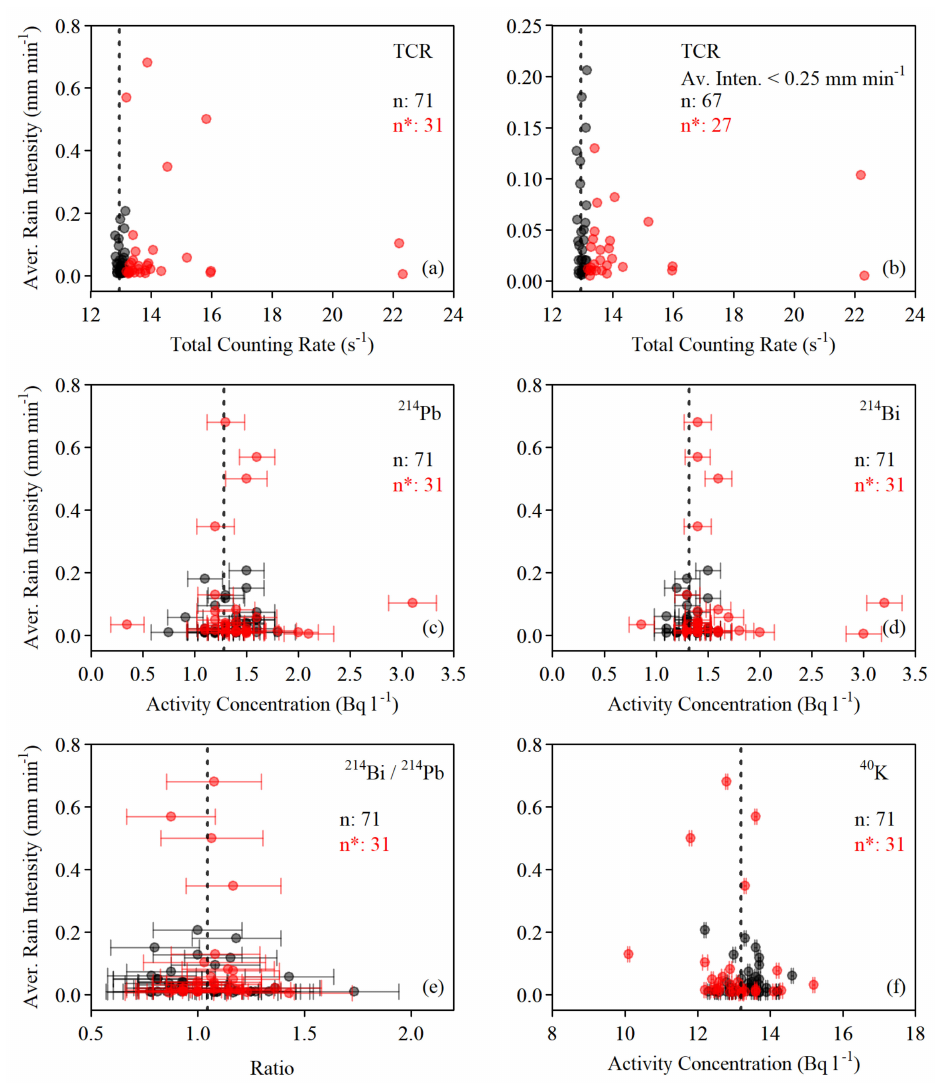
Figure 9. The average rainfall intensity over TCR ( a ), TCR for intensity lower than 0.25 mm min − 1 ( b ), 214 Pb ( c ), 214 Bi ( d ), radon progenies ratio ( e ) and 40 K ( f ). The total number of events is n . The events of statistically significant variation of TCR ( n *) are presented with red dots. The mean value of each parameter during dry meteorological periods is presented with a dotted